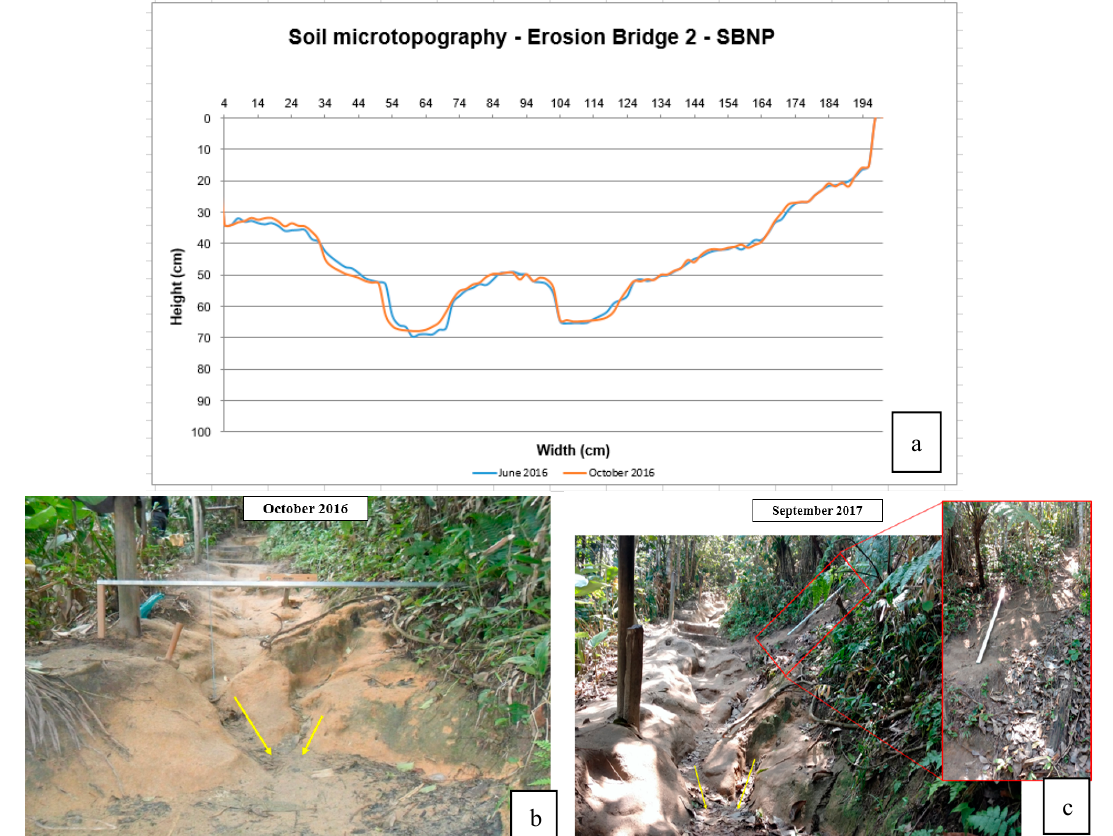
Figure 6. ( a ) Soil microtopographic analysis between June 2016 and October 2016 on EB2. ( b ) The yellow arrows indicate rills with litter accumulation in October 2016. ( c ) Landslide (detail in red) in September 2017. Photos: L. Rangel (2016 and 2017).